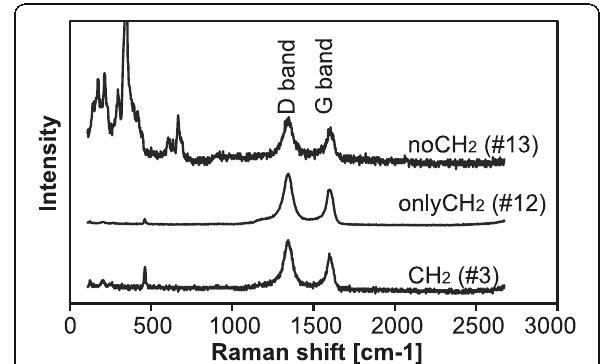
Fig. 6 Examples of Raman spectra of the carbonaceous clots. The spectra marked as CH 2 , CH 2 only, and no CH 2 were obtained from sample 96NP452 (CH 2 : both aliphatic CH 2 and CH 3 bonds were observed in micro-FTIR measurements; CH 2 only: CH 2 bond was observed but CH 3 was not; no CH 2 : neither CH 2 nor CH 3 were observed). Spot numbers (#3, #12, and #13) corresponding to Table 1 are also shown. The band around 464 cm − 1 is due to the quartz matrix of the silica